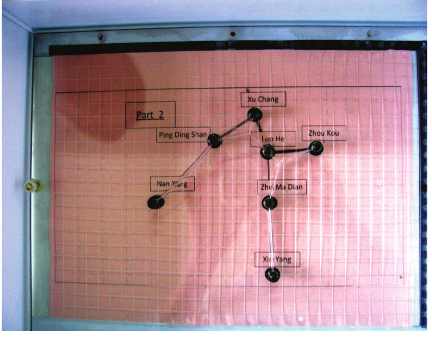
Figure 9: Experiment Pictures.